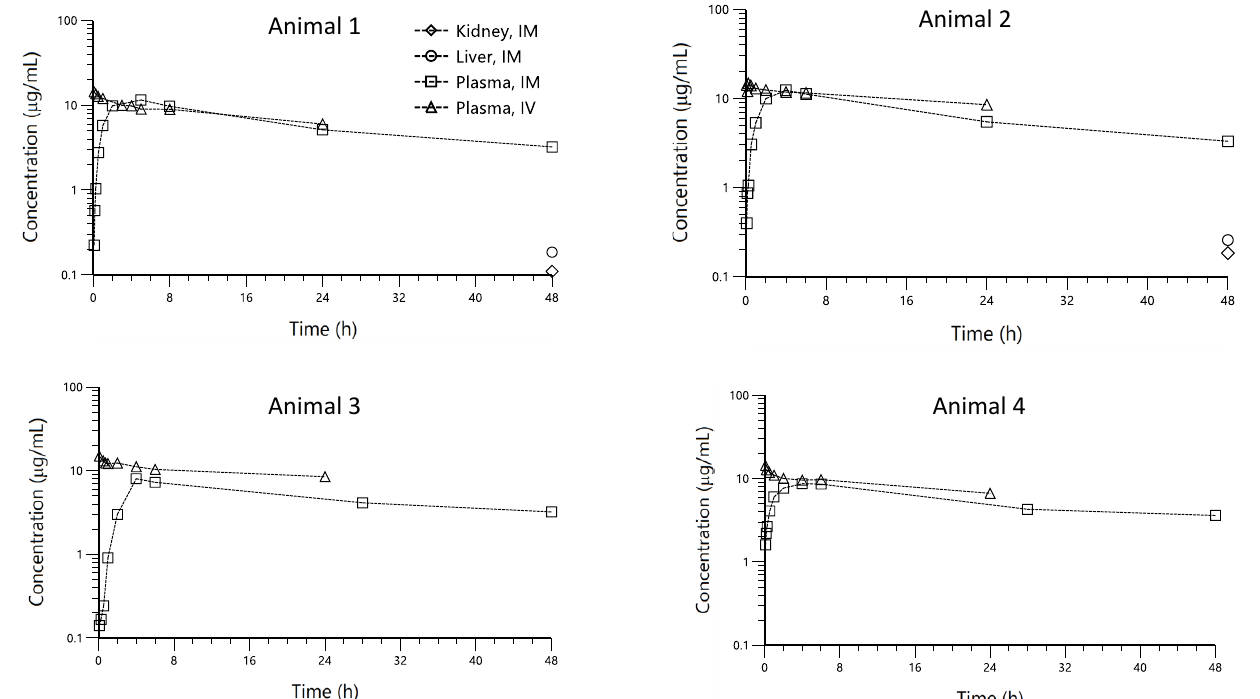
Figure 1. Overlayed individual plots of CP plasma concentration (µg/mL) vs. time (hr) profiles observed following intravenous (Δ) and intra -muscular ( ) administration at the dose of 4 mg/kg in swine, sorted by the animal. CP kidney (◊) and liver ( ○ ) concentrations at 48 h are also displayed for animals 1 and 2.